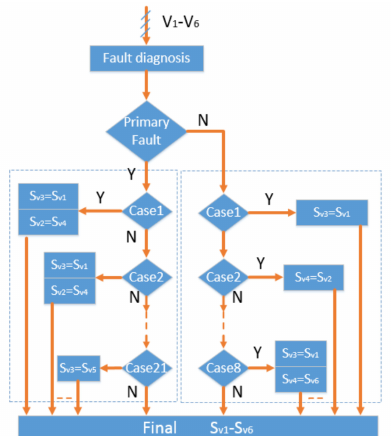
Figure 6. Reset rules of fault-tolerant pulse.